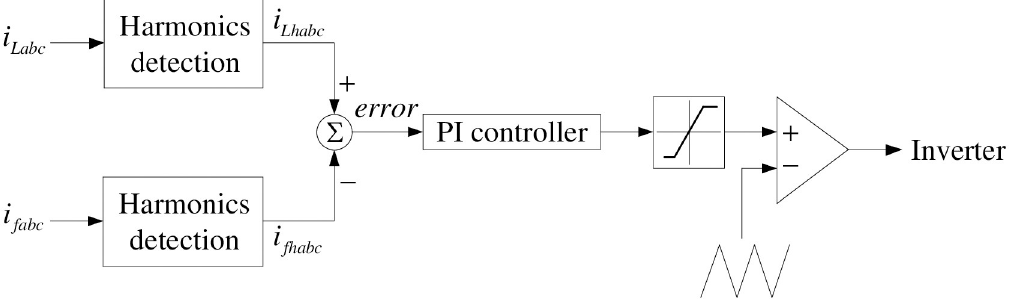
Fig 2. IHAPF control block